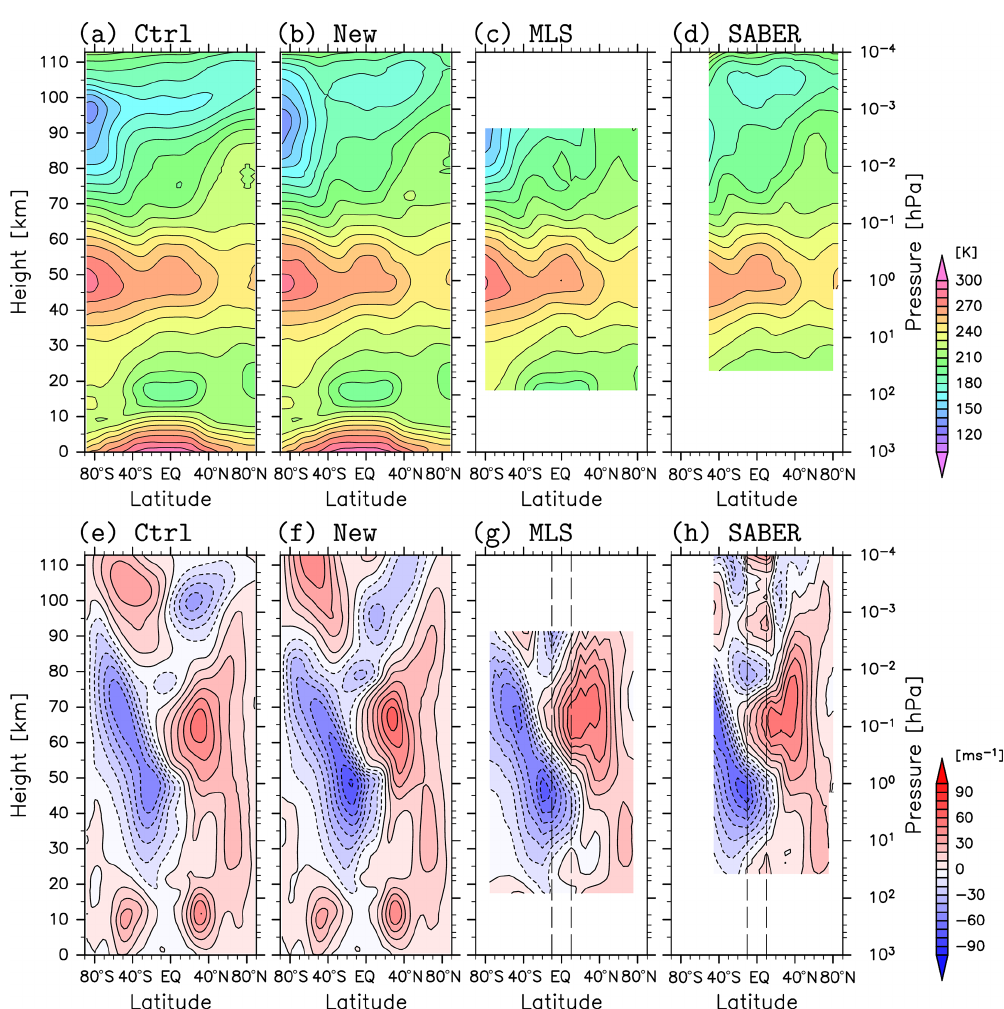
Figure 5. (a–d) Zonal mean temperature and (e–h) zonal wind for the time period of 15 January to 20 February 2017. The results in panels (a) and (e) are from the Ctrl (KSMW20) analysis, (b) and (f) are from the new analysis (Expt. IV), (c) and (g) are from the MLS observations, and (d) and (h) are from the SABER observations. The gradient winds from the satellite observations (g, h) at 10 ◦ S–10 ◦ N are linearly interpolated. Contour intervals are 10K for (a–d) and 10ms − 1 for (e–h)